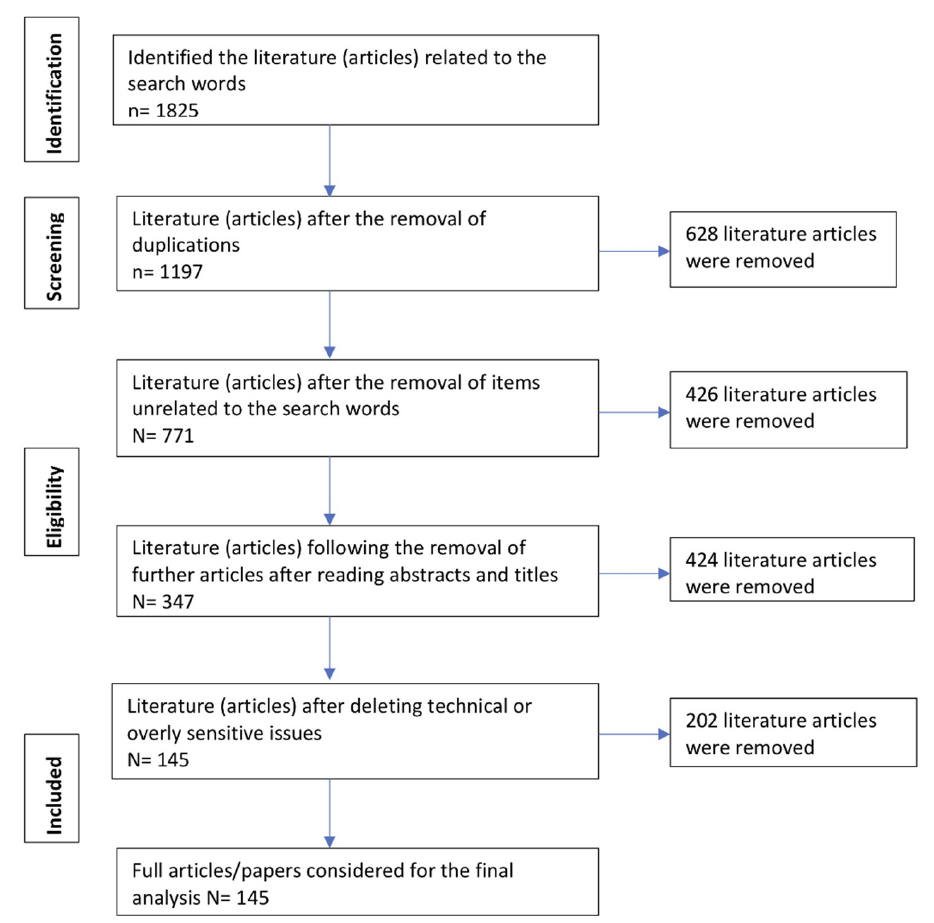
Figure 1. Systematic review—PRISMA model flow diagram (inclusion and exclusion criteria).